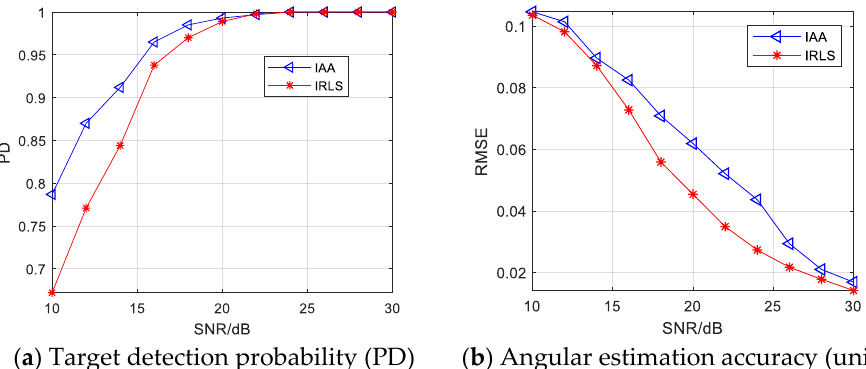
Figure 5. Target detection probability and angular measurement accuracy (single target without interference).